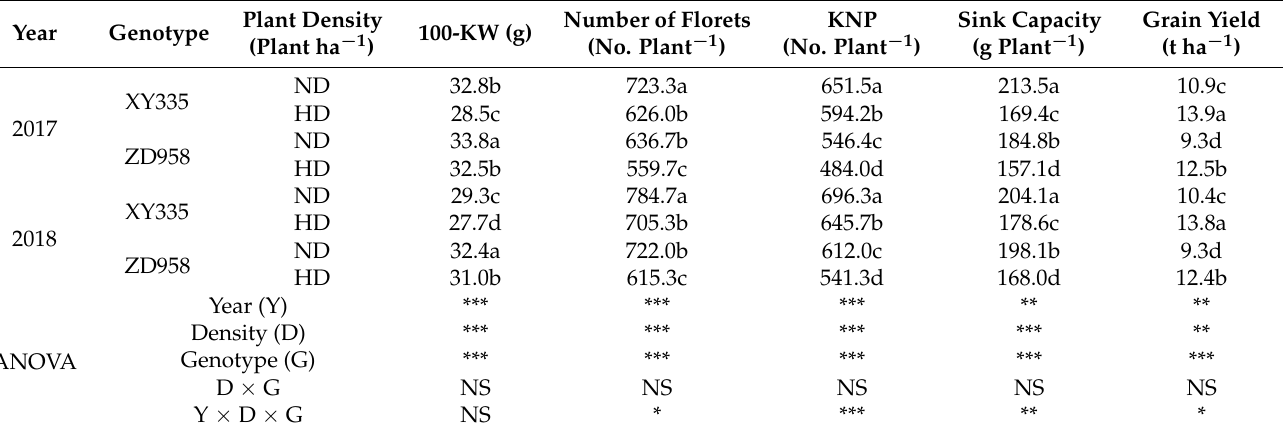
Table 1. Effect of plant density on florets, grain yield and sink capacity between two maize hybrids in 2017 and